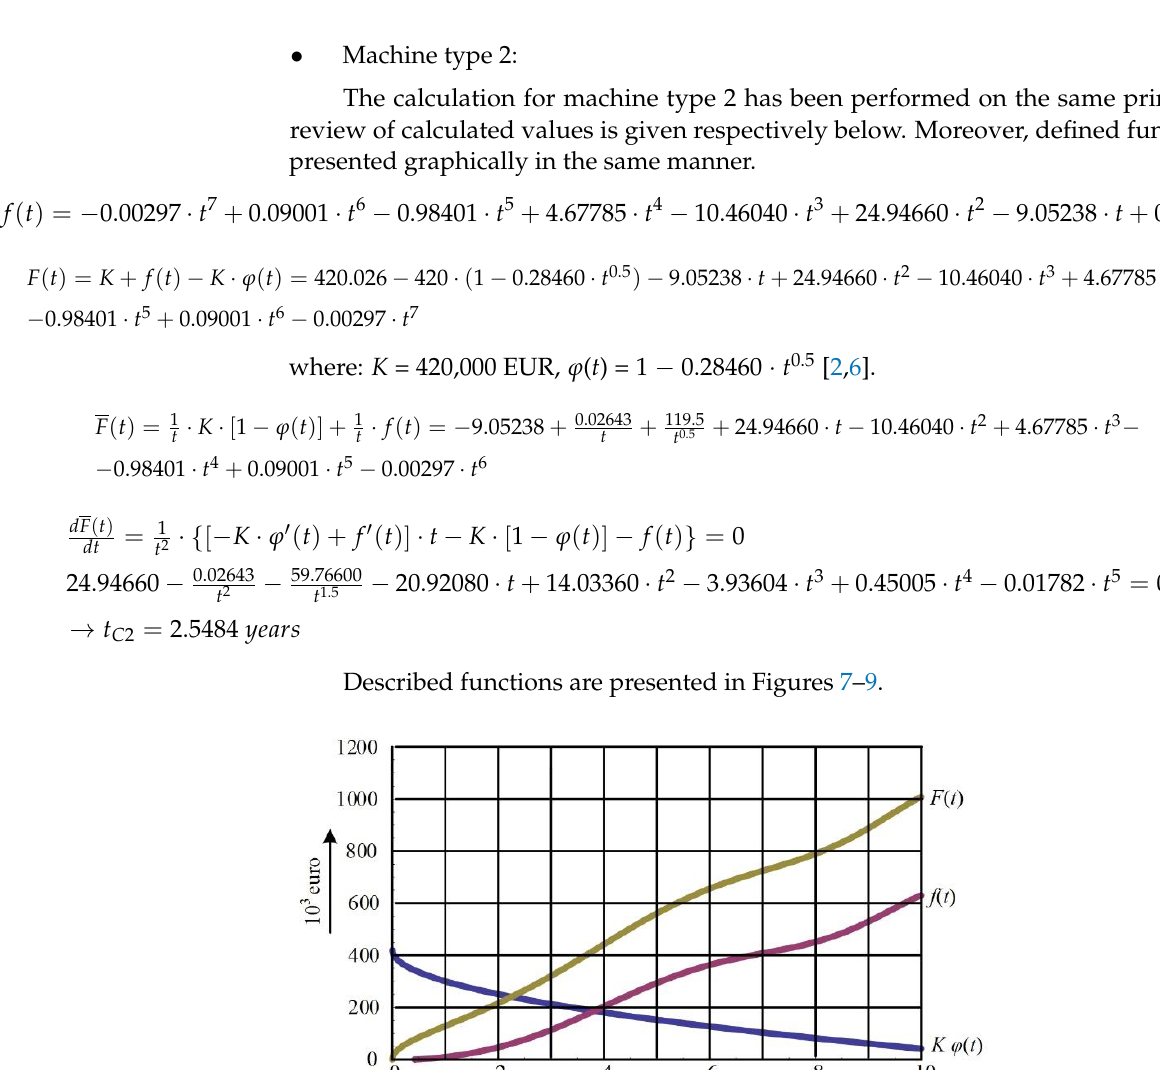
Figure 6. The first and second derivative of a function of average costs for the machine type 1